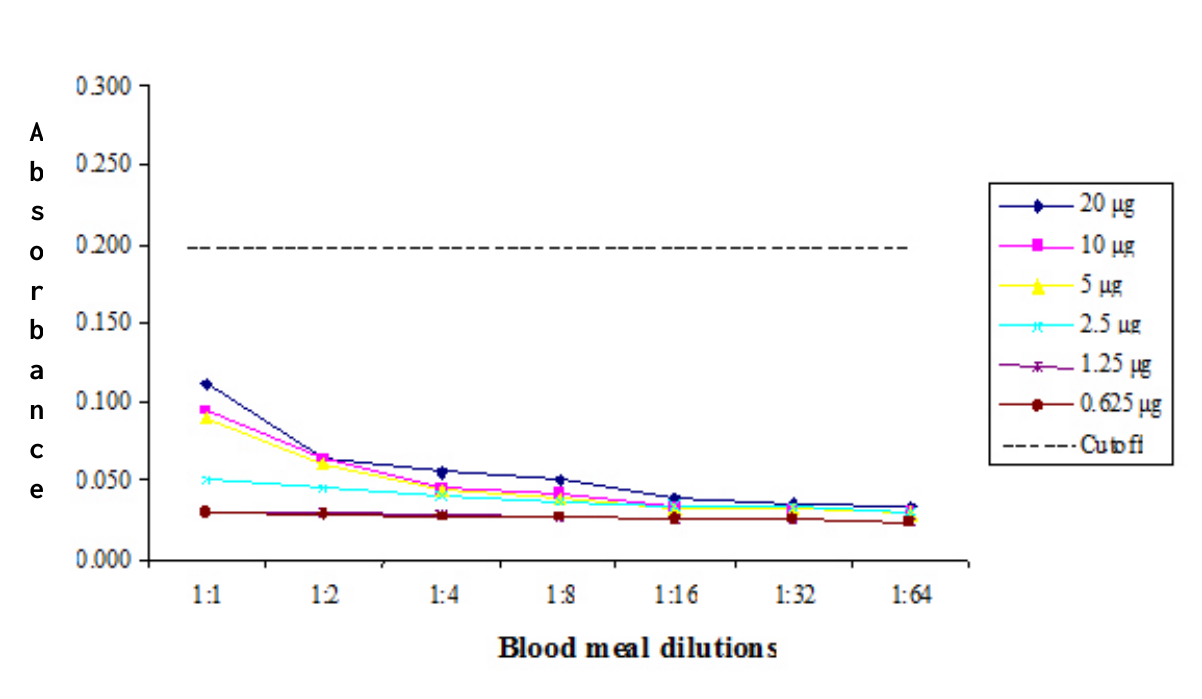
Figure 2. ELISA optimization with monoclonal anti-human